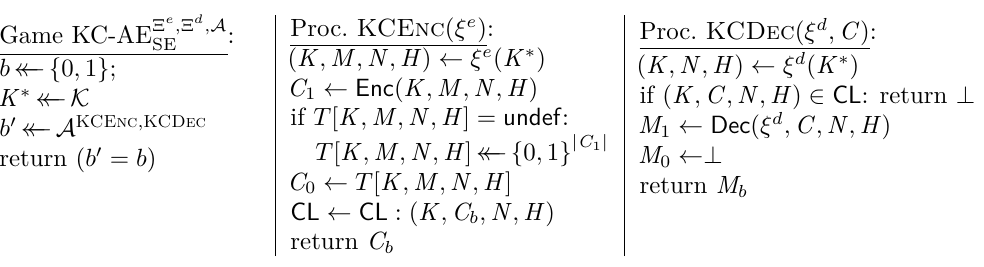
Figure 7: the game defining the KC-AE security of SE with key-correlated inputs and private headers and nonces (which are not revealed to the adversary). The adversary is required not to repeat nonces in its KCEnc